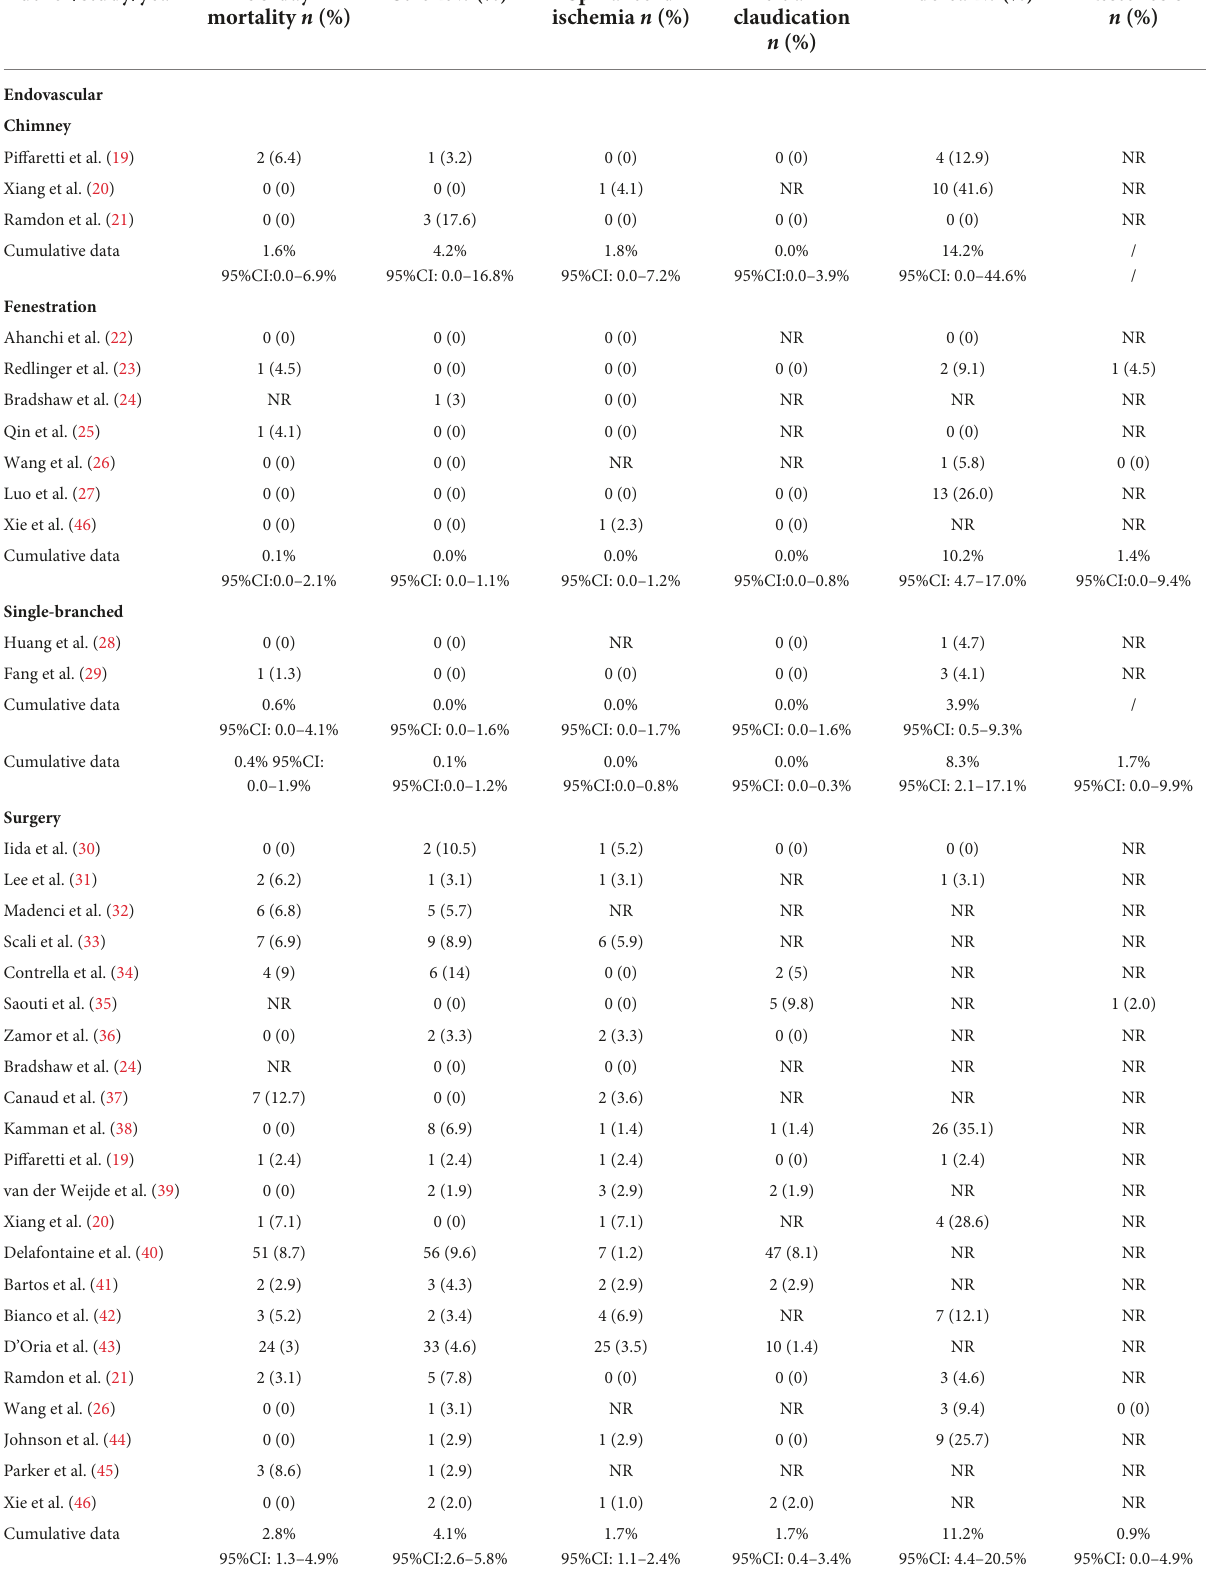
TABLE 1 Data on early and late outcomes following endovascular revascularization and surgical